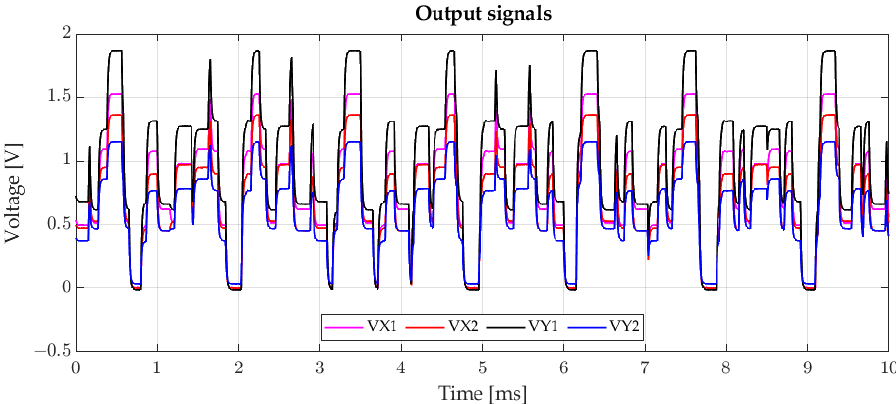
Figure 11. Output signals from PSD sensor.